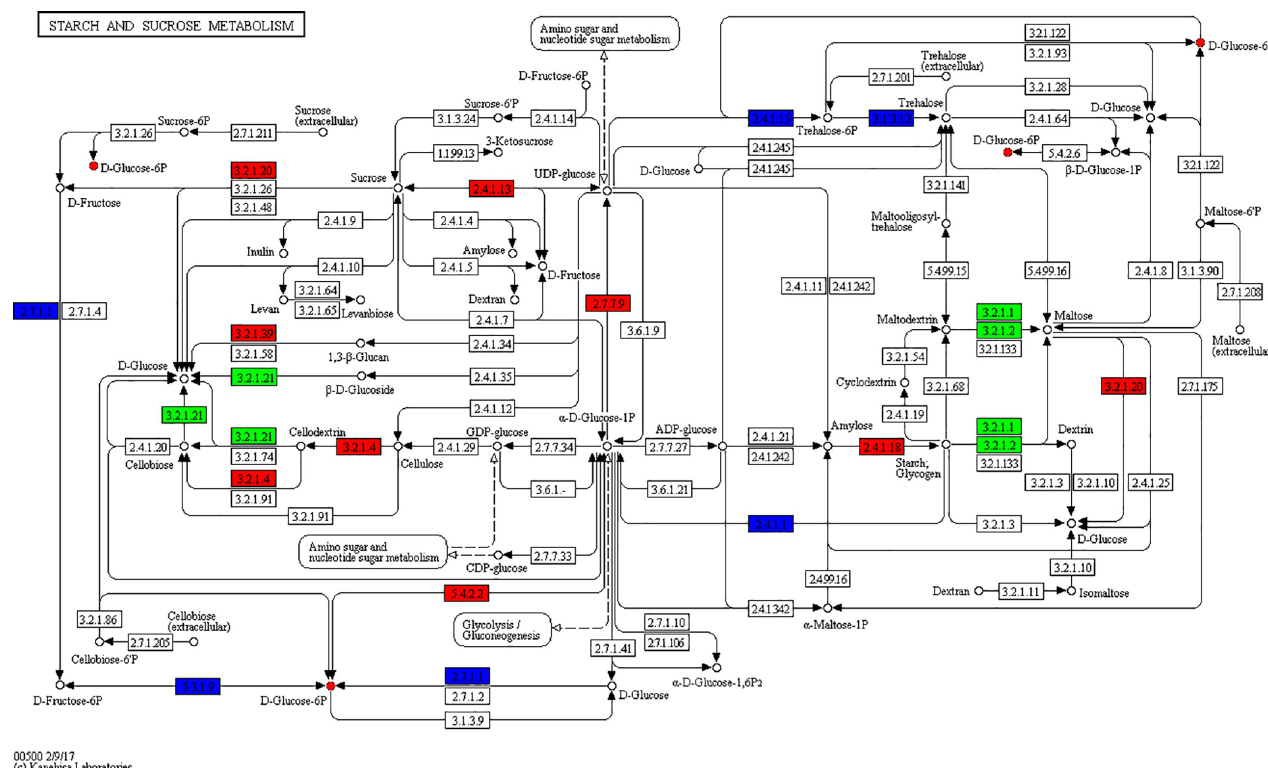
Fig 7. Starch and sucrose metabolism